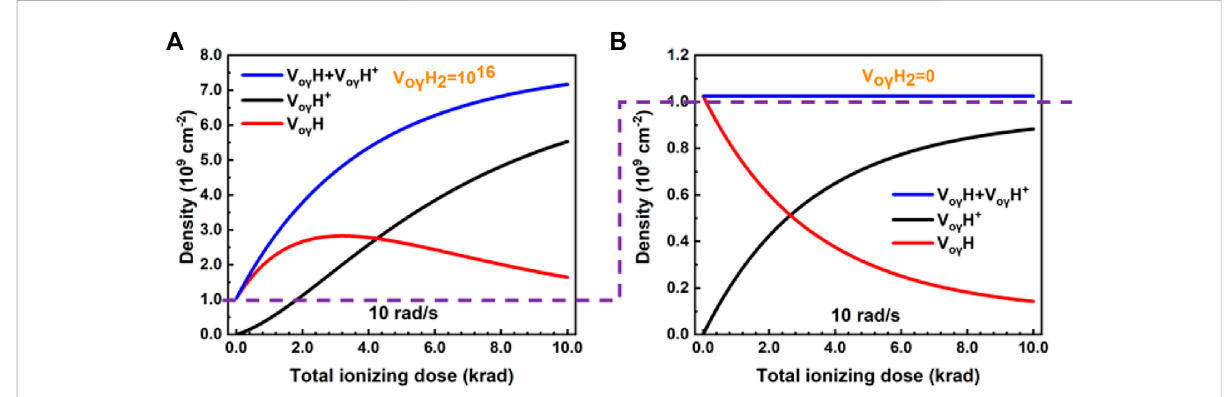
FIGURE 5 Evolution of V o γ H + , V o γ H and V o γ H + + V o γ H (A) with and (B) without V o γ H 2 as a function of TID at the dose rate of 10 rad/s at 300K.